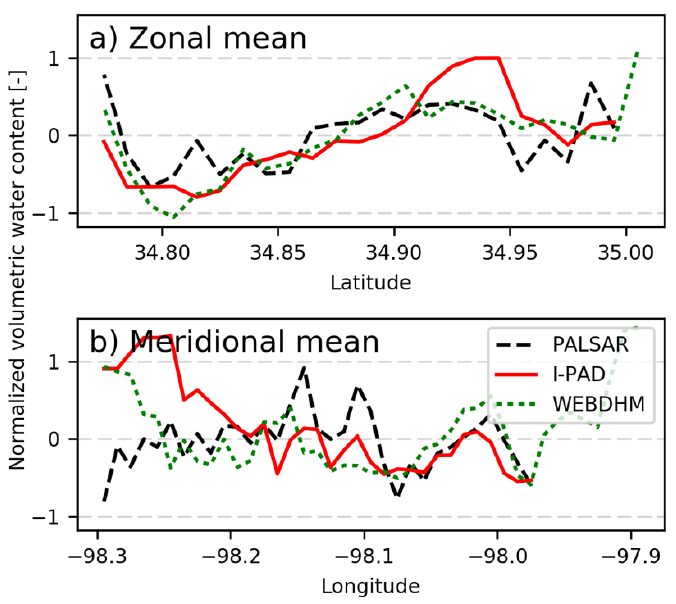
Figure 11. ( a ) Zonal mean and ( b ) meridional mean of normalized surface soil moisture on 2 March 2007. Black dashed line, PALSAR observation; red line, I-PAD; green dotted line, WEB-DHM.